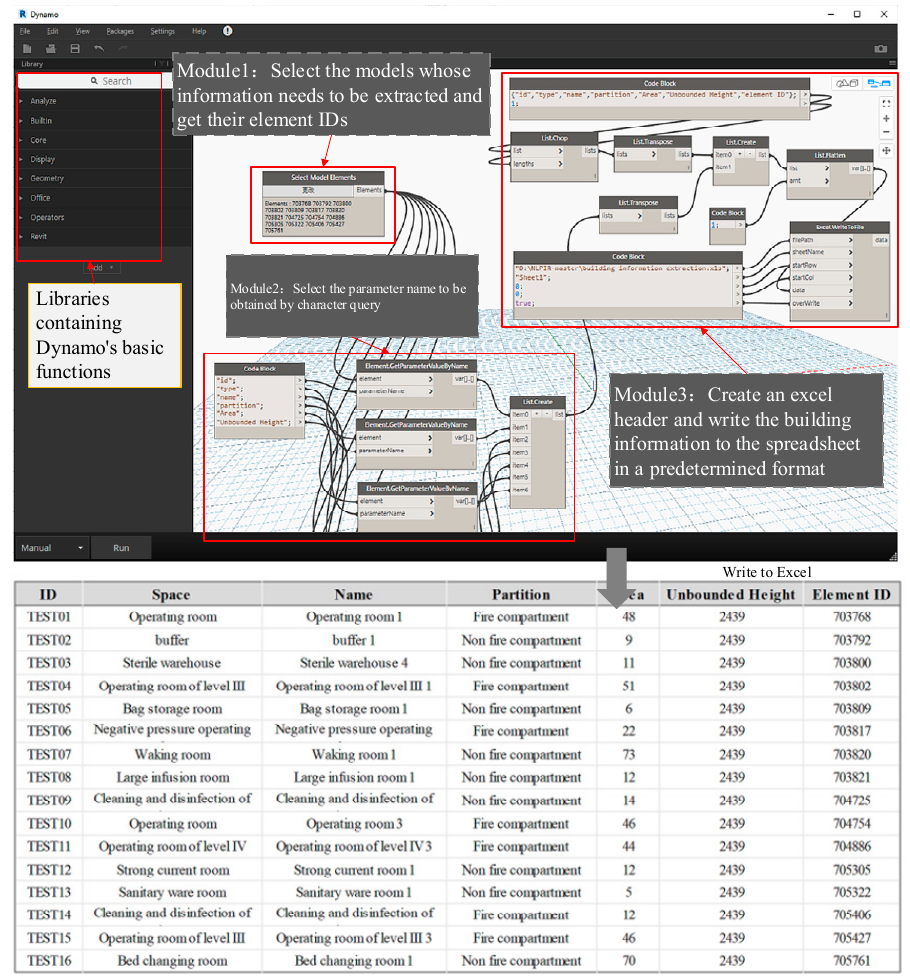
Figure 11. BIM data extraction via Dynamo.